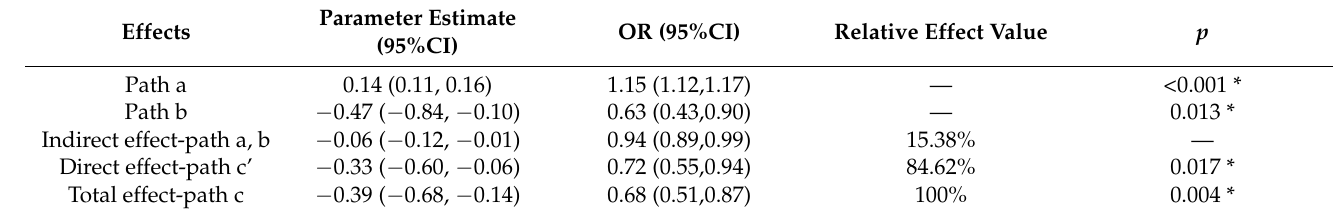
Table 4. Mediation analysis of the relationship between 25(OH)D 3 levels and T2DM by